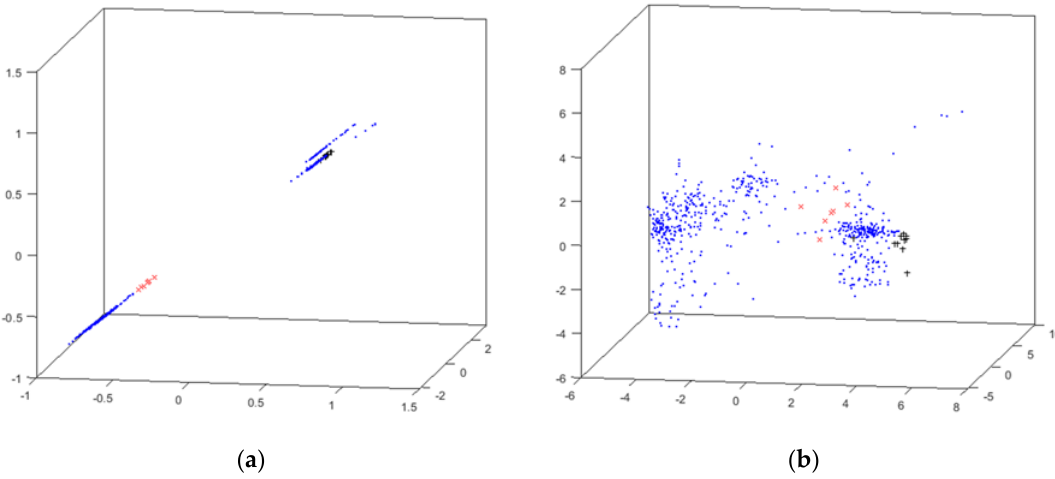
Figure 7. 3D visualizations generated by EPP methods for the cyclone dataset. ( a ) CMLHL 3D visualization. ( b ) CMDS–Seuclidean 3D visualization.